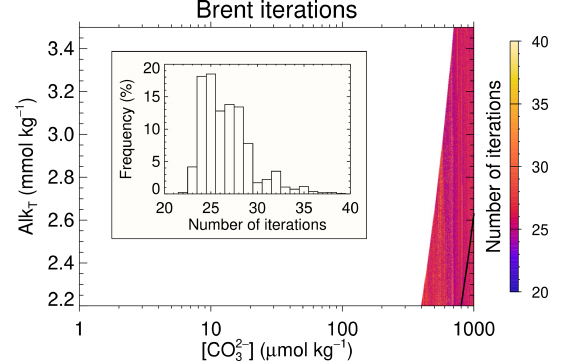
Figure 8. Number of iterations required by Brent’s algorithm in the SW2 test case to solve the auxiliary minimisation problem whose solution determines the number of roots of the Alk T –CO 2 − also provides the separation between the two roots. The white area covers the region where the solution of the minimisation problems is not required as Alk T is sufficiently high so that there were two roots. The insert shows the frequency distribution of the number of iterations required. The black line in the lower right corner traces the limit between regions with two roots and without roots (compare with Fig. 5c and